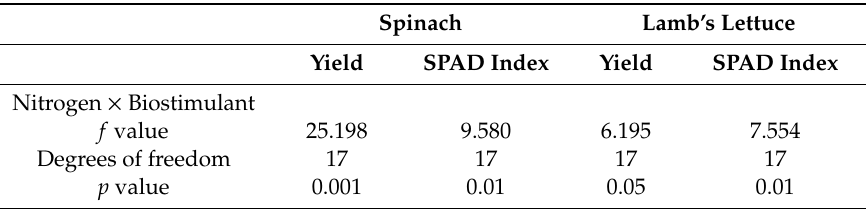
Table 1. Analysis of variance of marketable fresh yield and SPAD index of spinach and lamb’s lettuce (Figures 1A,B and 2A,B).